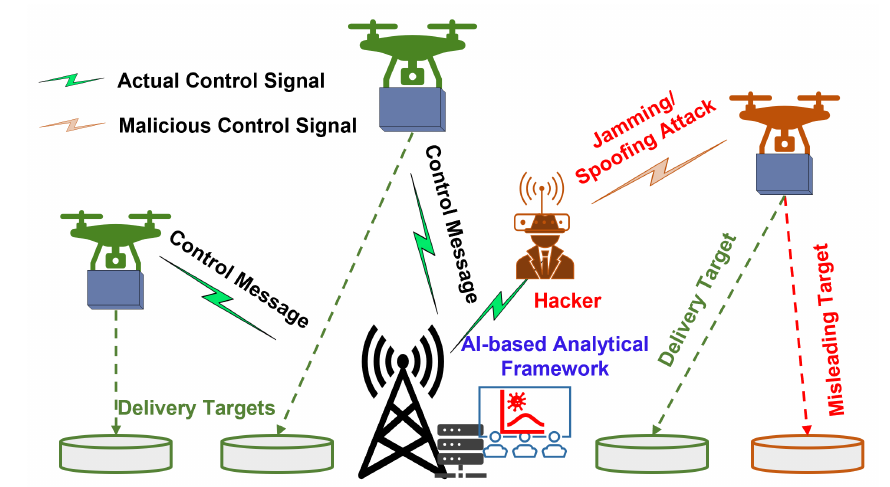
Figure 1. System model of urban air mobility cyber-physical